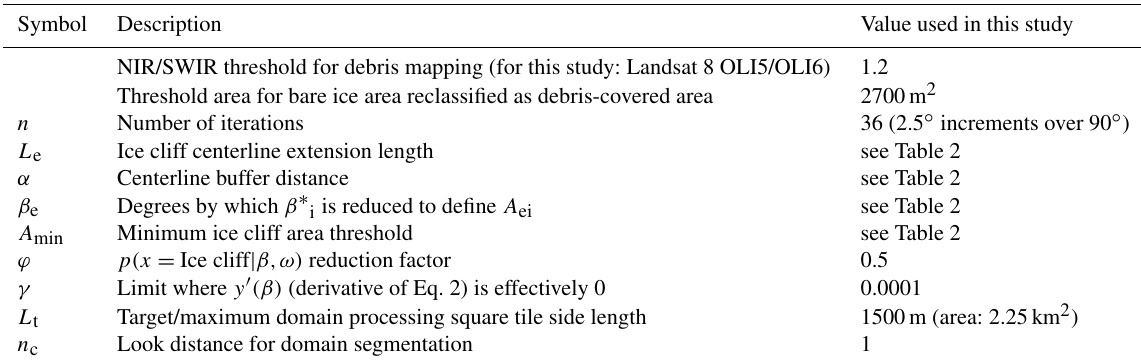
∗ Table 1. Model parameters. Where β i is the surface slope threshold that defines the base ice cliff shape ( A i ) for each iteration, A ei is the same as A i but with a slightly lower surface slope threshold and p(x = Ice cliff | β,ω) is ice cliff probability given surface slope and overlap with A cliff (Sect. 3.2.1). Look distance is the number of L t × L t cells the routine will look beyond and still consider as “neighboring” during segmentation of a spatial domain greater than L 2 t . Symbol Description Value used in this study NIR/SWIR threshold for debris mapping (for this study: Landsat 8 OLI5/OLI6) 1.2 Threshold area for bare ice area reclassified as debris-covered area 2700m 2 36 (2.5 ◦ increments over 90 ◦ ) see Table 2 see Table